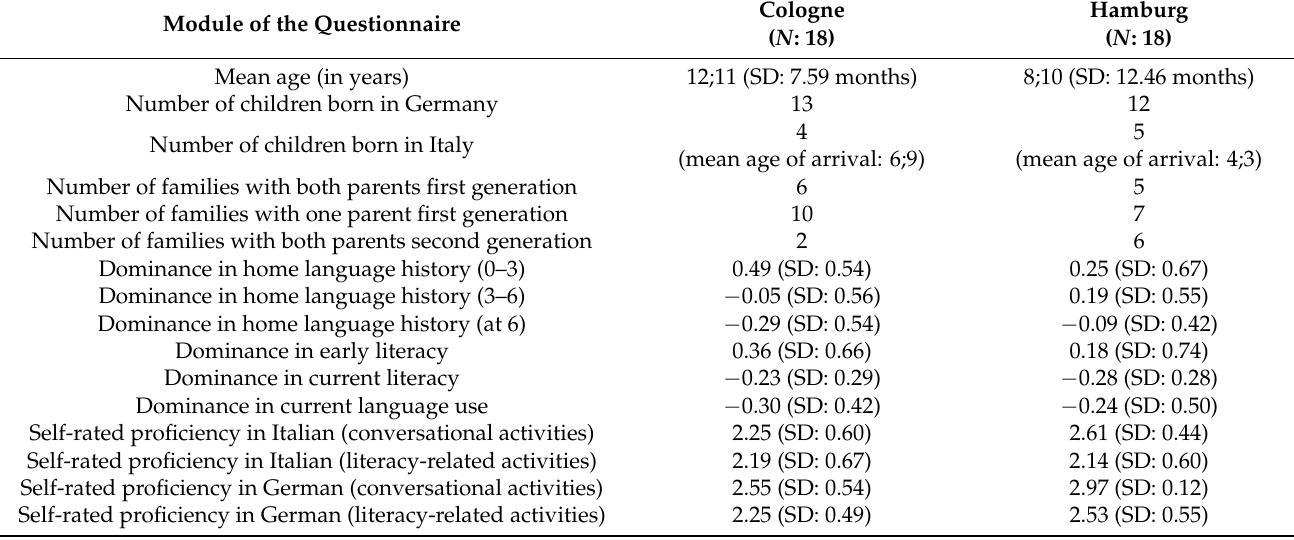
Table 2. Descriptive statistics for the different modules of the questionnaire across the two family groups (living in Cologne and Hamburg). The numbers corresponding to the modules related to dominance across different contexts refer to the difference between the score obtained in Italian and the score obtained in German in the corresponding module of the questionnaire, whereby a positive score indicates dominance in Italian and a negative score indicates dominance in German. Module of the